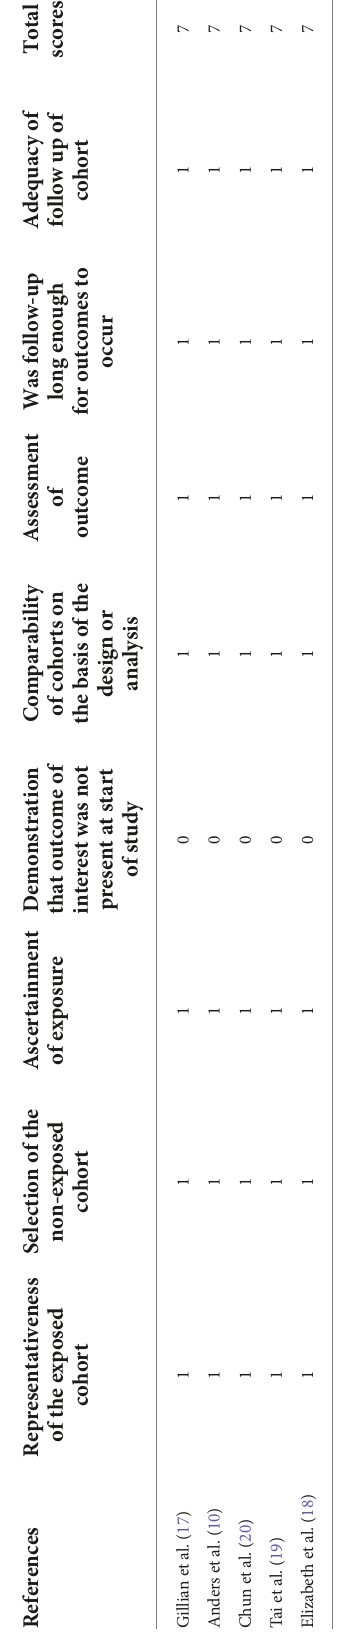
Figure 3 . The results did not reverse suggesting the stability and